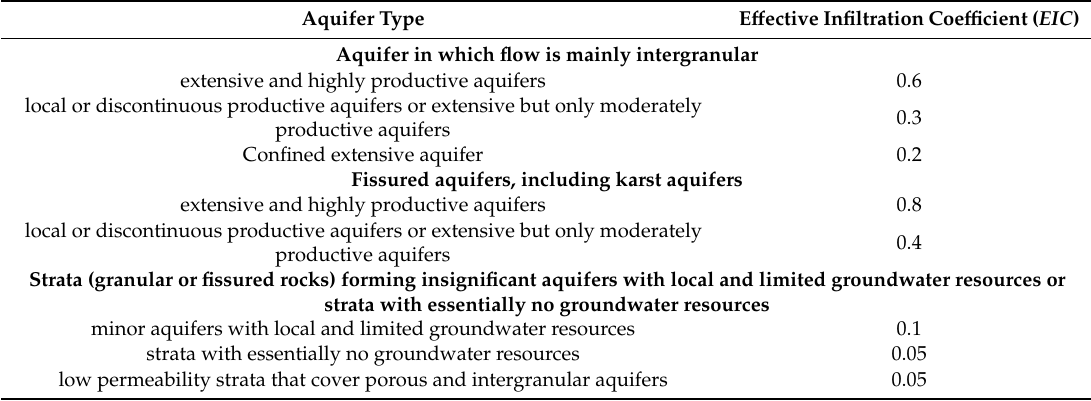
Table 2. E ff ective infiltration factor ( EIC ) (modified from ˇCenˇcur Curk et al.